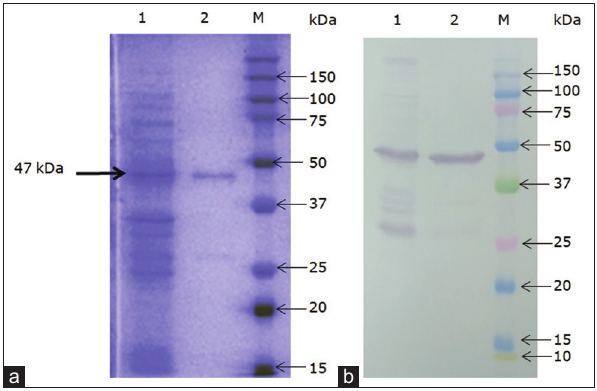
Figure-3: Sodium dodecyl sulfate-polyacrylamide gel electrophoresis (a) and western blotting (b) of rP32Trx protein. Line 1: Total cell lysate of Escherichia coli BL21(DE3) containing pET32a/P32, 6 h incubation after isopropyl- β